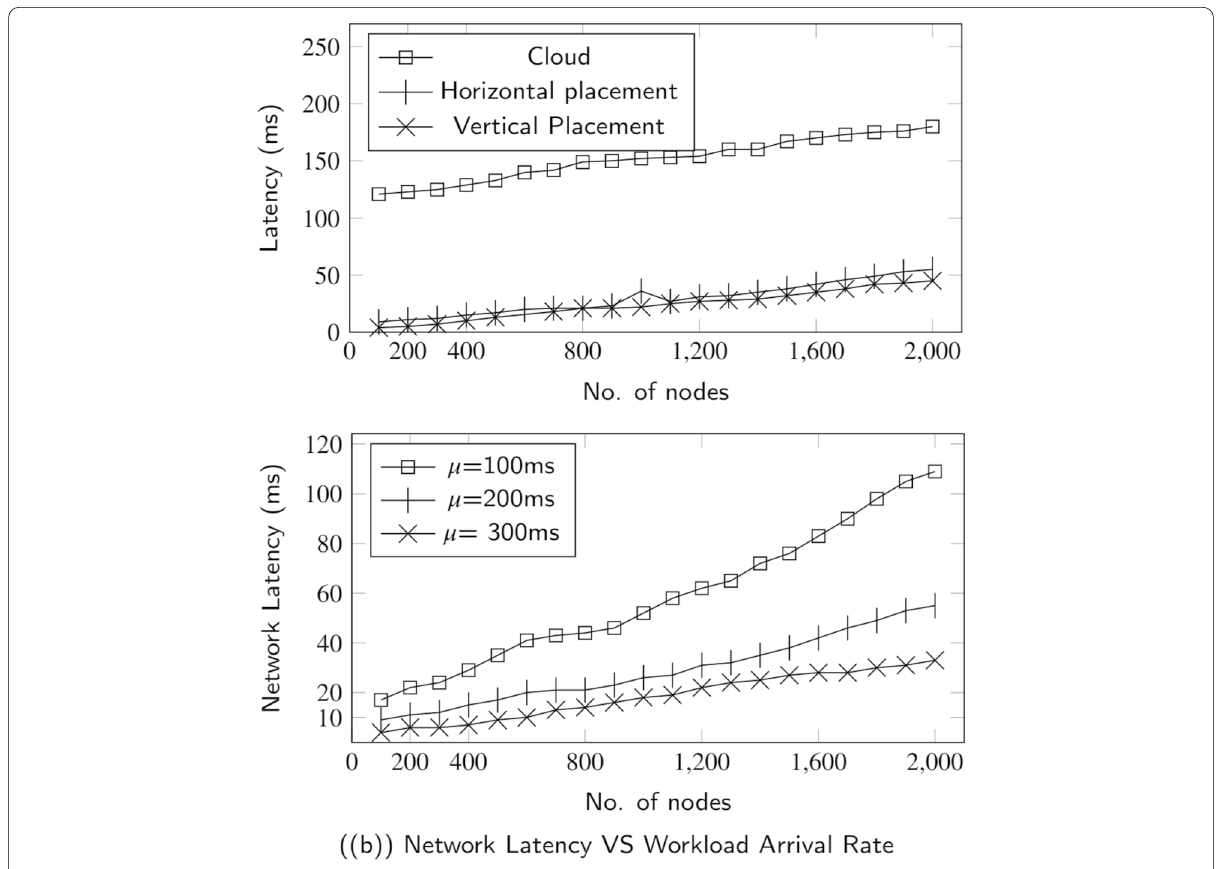
Fig. 6 Network latency time with different arrival rate and network setup